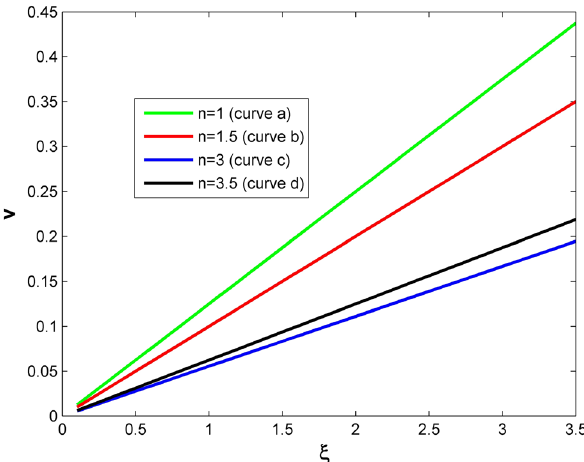
Fig. 4 Graphs between ξ and